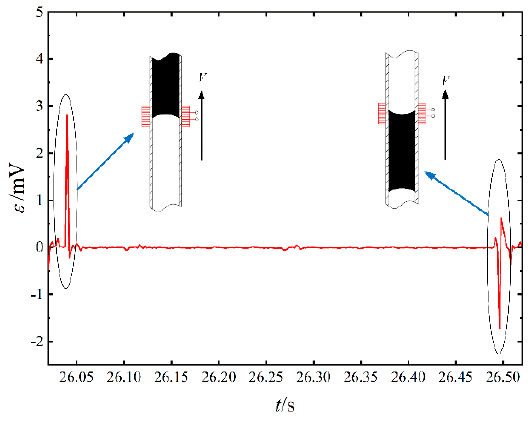
Figure 10. The voltage waveform for 3.83% magnetic fluid at 150 W.